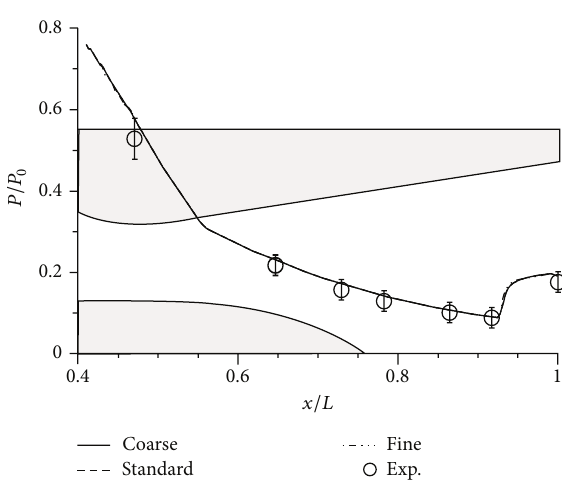
Figure 6: Effect of mesh refinement on the static pressure distribu-